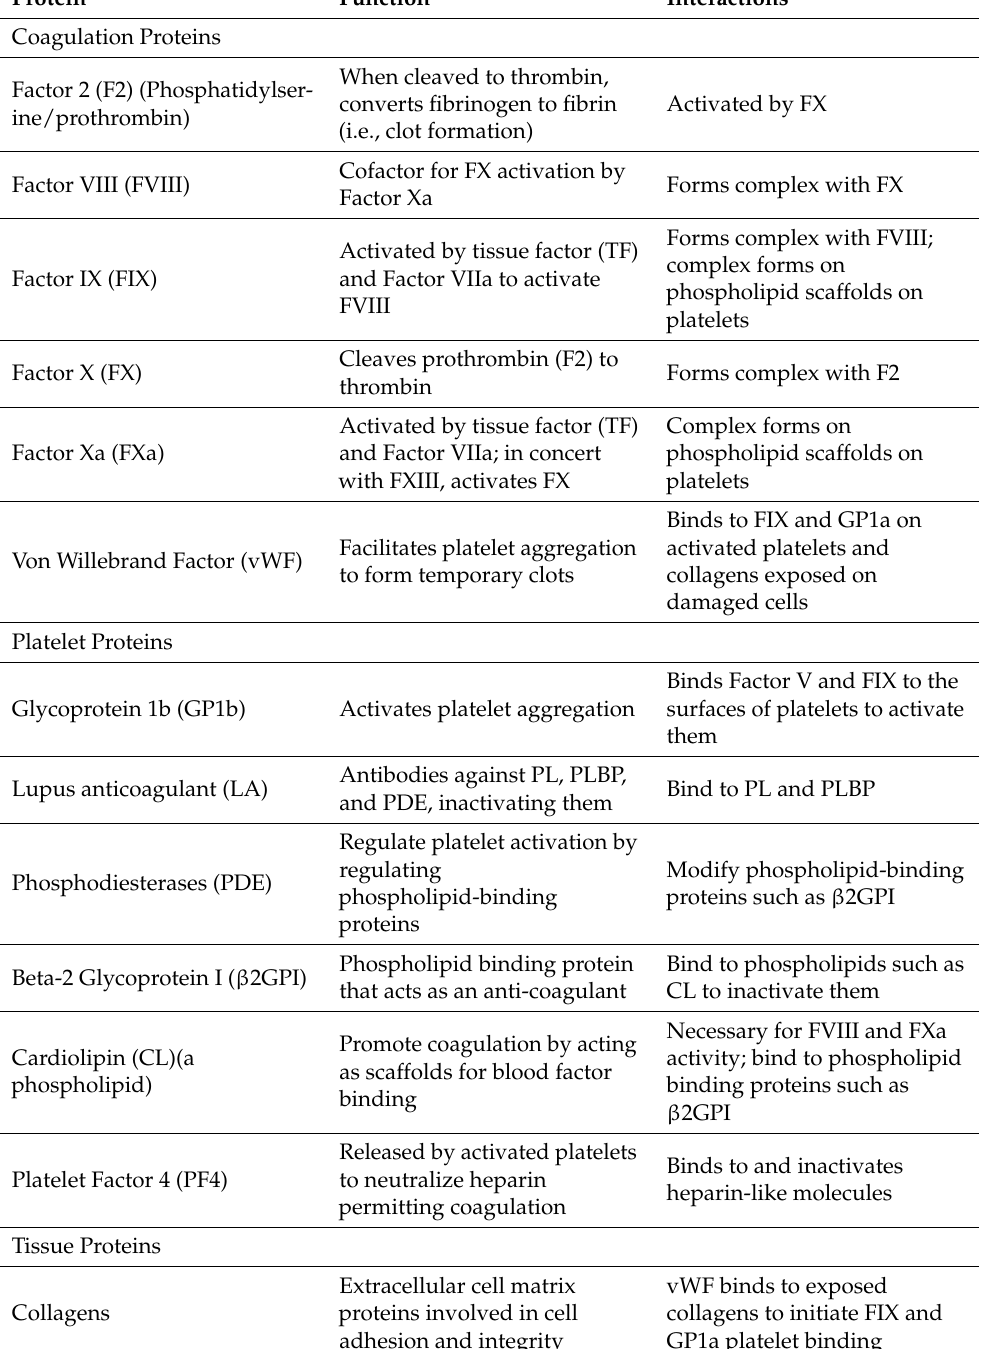
Table 1. Proteins involved in blood coagulation that are targets of autoantibodies in COVID-19 patients and the functions and interactions among these